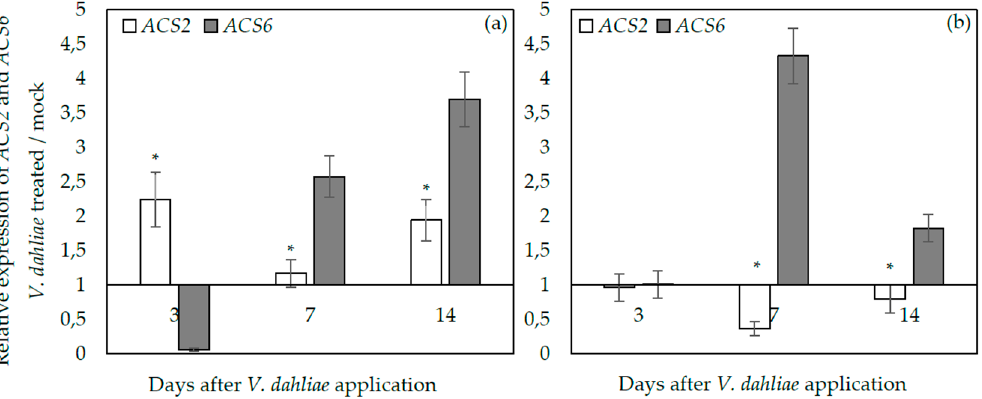
Figure 4. Relative transcript abundance of ACS2 and ACS6 in the above ground plant parts (leaves and stems) ( a ) and root ( b ) in wild type Arabidopsis thaliana plants inoculated with Verticillium dahliae , at 3, 7, and 14 days post-inoculation. Transcript levels of the examined genes were normalized to the expression of the plant gene At4g26410 measured in the same samples and expressed relative to the normalized transcript levels in mock-treated plants. The experiment was repeated three times with similar results. The columns represent the means of 3 technical repeats of three biological repeats and the vertical bars indicate the standard errors. At each day, columns with asterisks (*) are significantly different ( p < 0.05) from ACS6 according to a t -test.